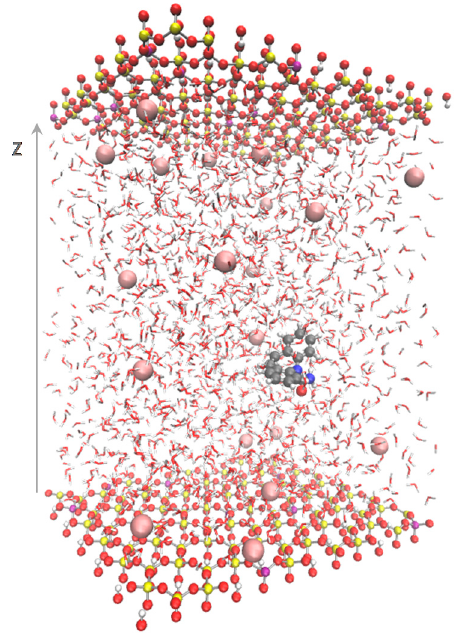
Figure 3. Simulation box with carbamazepine at the center as the initial structure for the produc- tion.